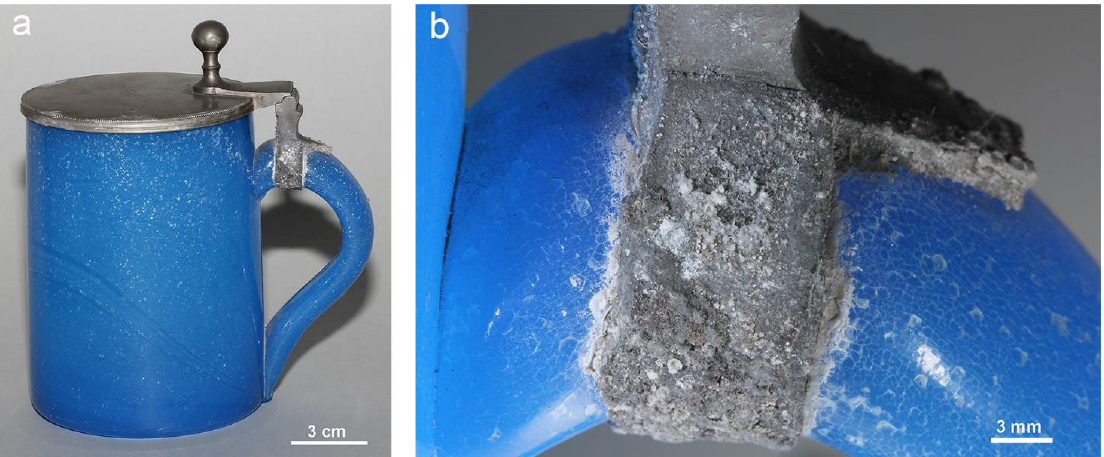
Figure 3. ( a ) Potash glass beer jug, ca. 1800 AD, Kunstsammlungen der Veste Coburg, ( b ) corrosion on lead-tin alloy.